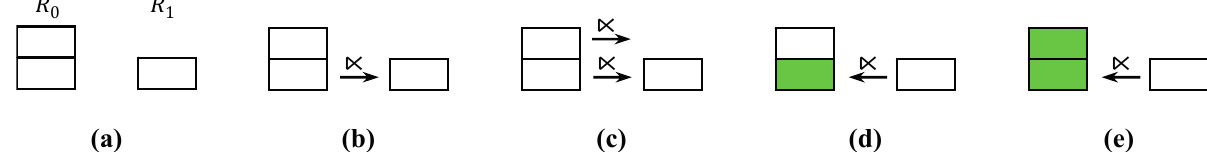
Figure 6. Optimal Solution from Initialization. ( a ) Two fragments remaining in (cid:1844)